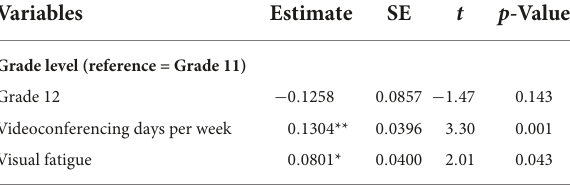
TABLE 4 Multiple regression test of demographic, digital use, and videoconferencing fatigue determinants of online student